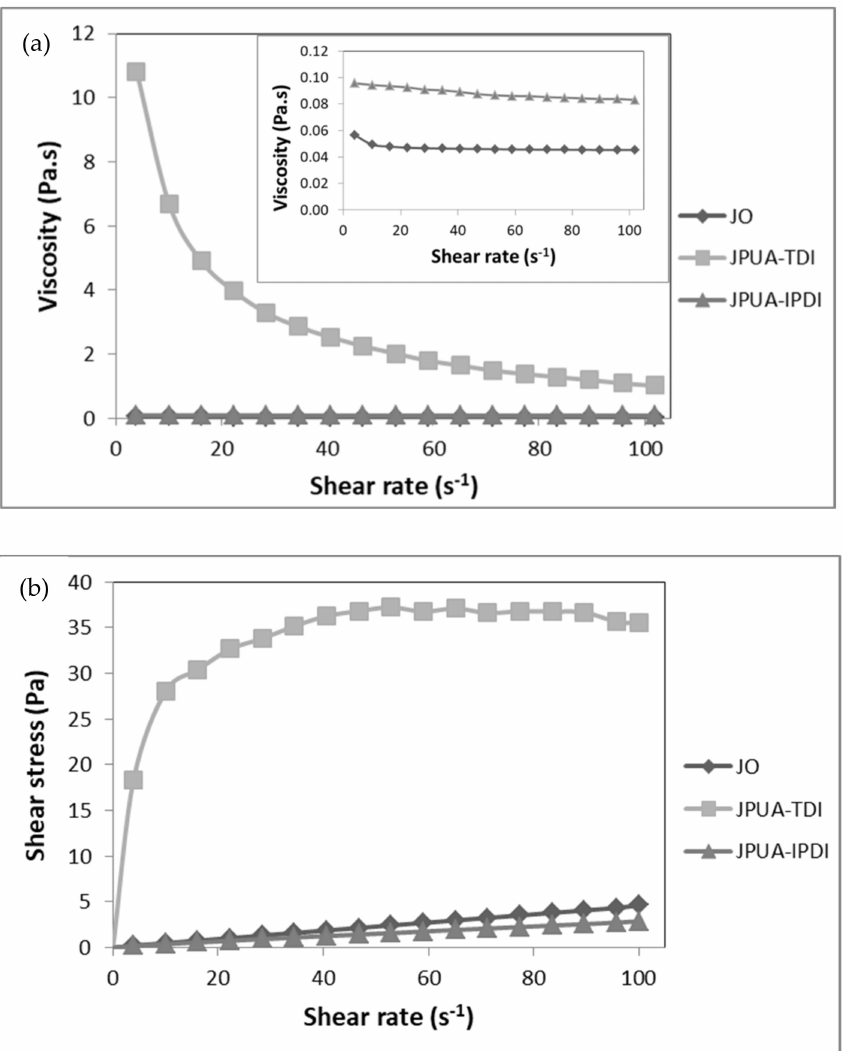
Figure 3. ( a ) Viscosity and ( b ) shear stress relationship with shear rate of JO, JPUA-TDI and JPUA-IPDI. As seen in the graph in the inset of Figure 3a, both JO and JPUA-IPDI showed almost constant viscosity of around 0.05 and 0.09 Pa.s, respectively, within the total range of the applied shear rate. Moreover, a linear relationship between shear stress and shear rate was observed for JO and JPUA-IPDI, as depicted in Figure 3b. These findings reflected the Newtonian fluid behaviour of JO and JPUA-IPDI, as stated by Saalah et al. [49]. In contrast, the nonlinear curve between the shear rate and shear stress in Figure 3b revealed